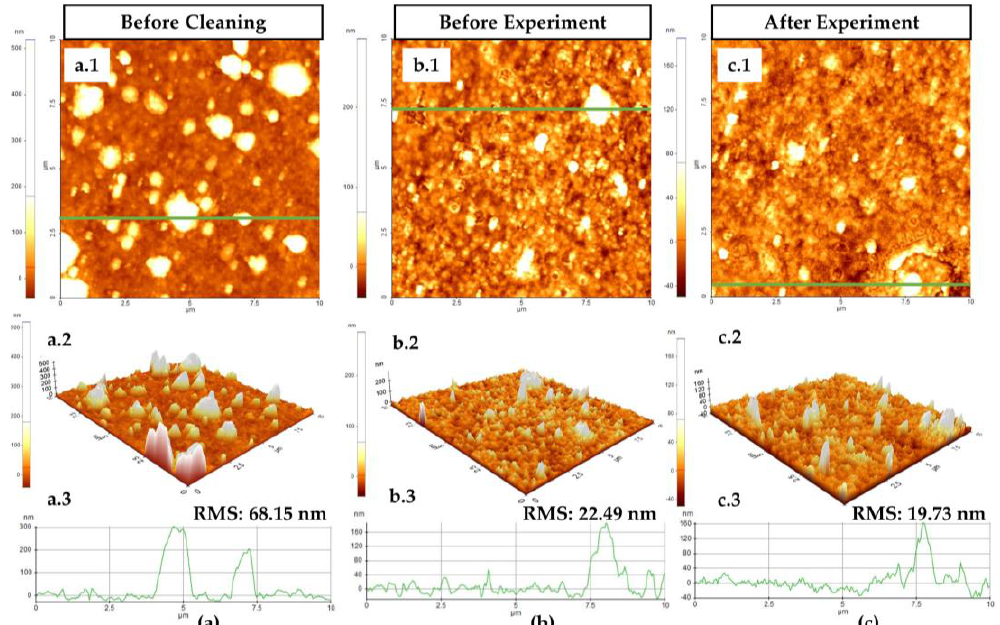
Figure 5. Surface morphological conditions. ( a ) Before cleaning: ( a.1 ) the two-dimensional (2-D) view of the unloaded surface; ( a.2 ) the three-dimensional (3-D) surface profile; ( a.3 ) the line profile for surface roughness distribution of green line. ( b ) Unloaded chip condition before the experiment: ( b.1 ) the 2-D view of the surface condition; ( b.2 ) the 3-D surface profile; ( b.3 ) the line profile distribution of green line; ( c ) Chip condition after multiple experiments: ( c.1 ) the 2-D view of the surface condition; ( c.2 ) the 3-D surface profile; ( c.3 ) the line profile for surface roughness distribution of green line.